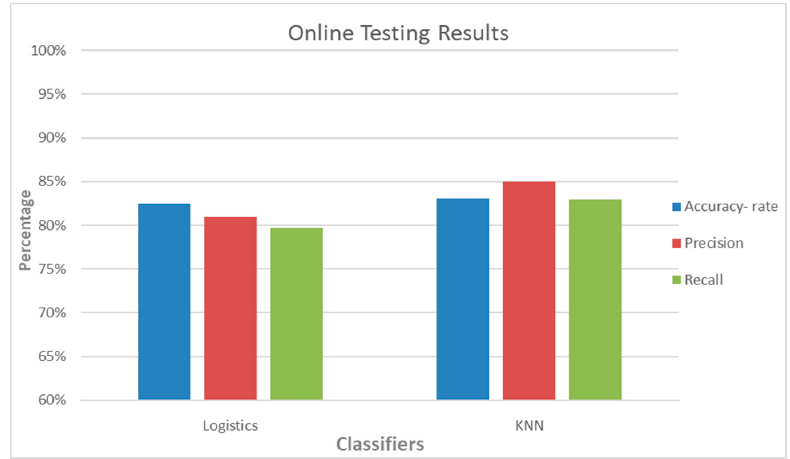
Figure 8. Online Analysis of the different classifiers.